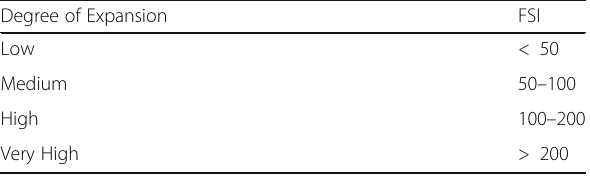
Table 4 Expansive soil classification based on FSI